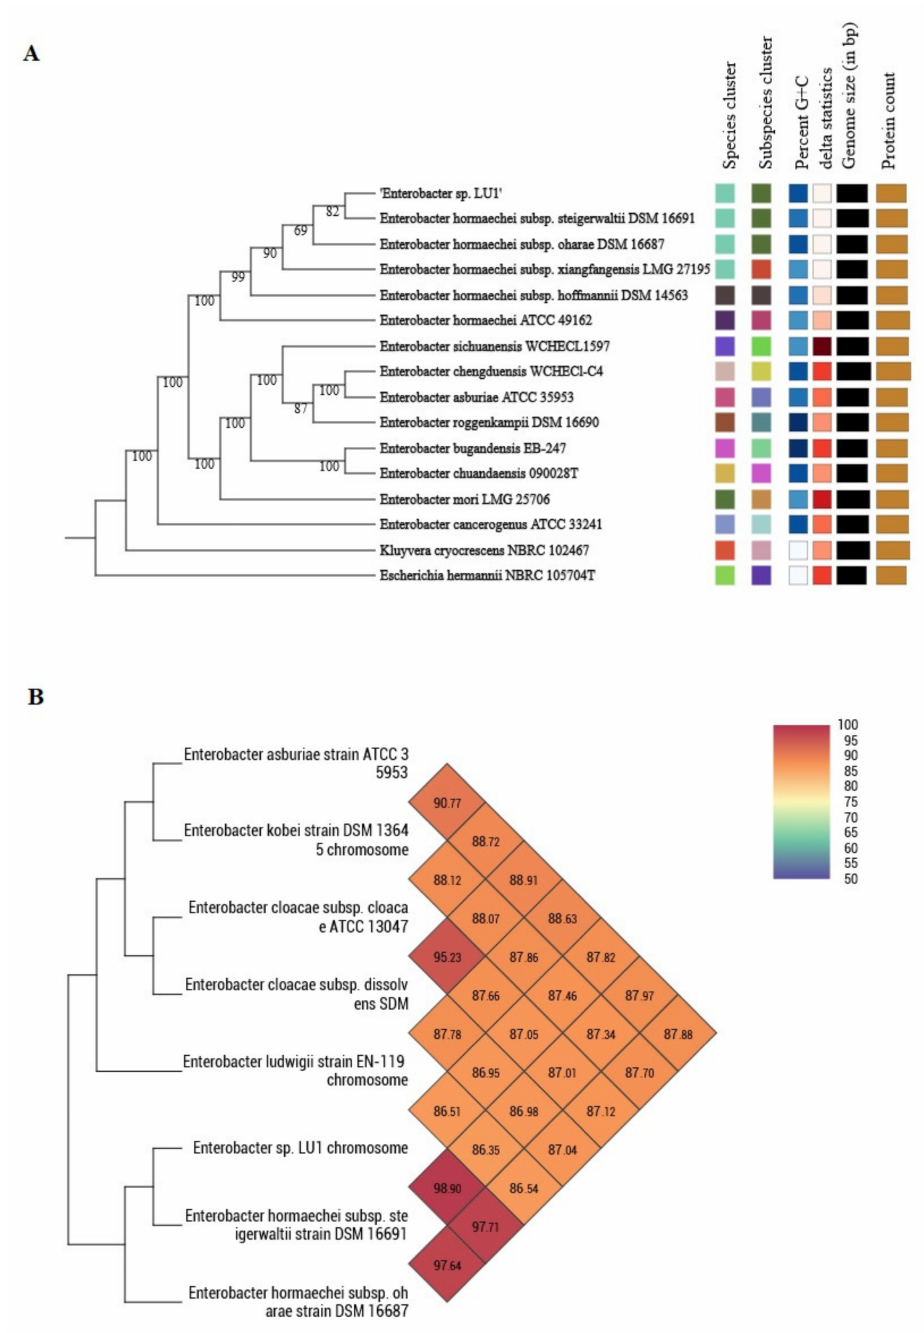
Figure 1. Phylogenomic classification of Enterobacter sp. LU1 strain based on: ( A ) Genome Basic Local Alignment Search Tool (BLAST) distance phylogenies (GBDP) using Type Strain Genome Server (TYGS) platform [23]. Tree was inferred with FastME 2.1.6.1 [29] from GBDP distances calculated